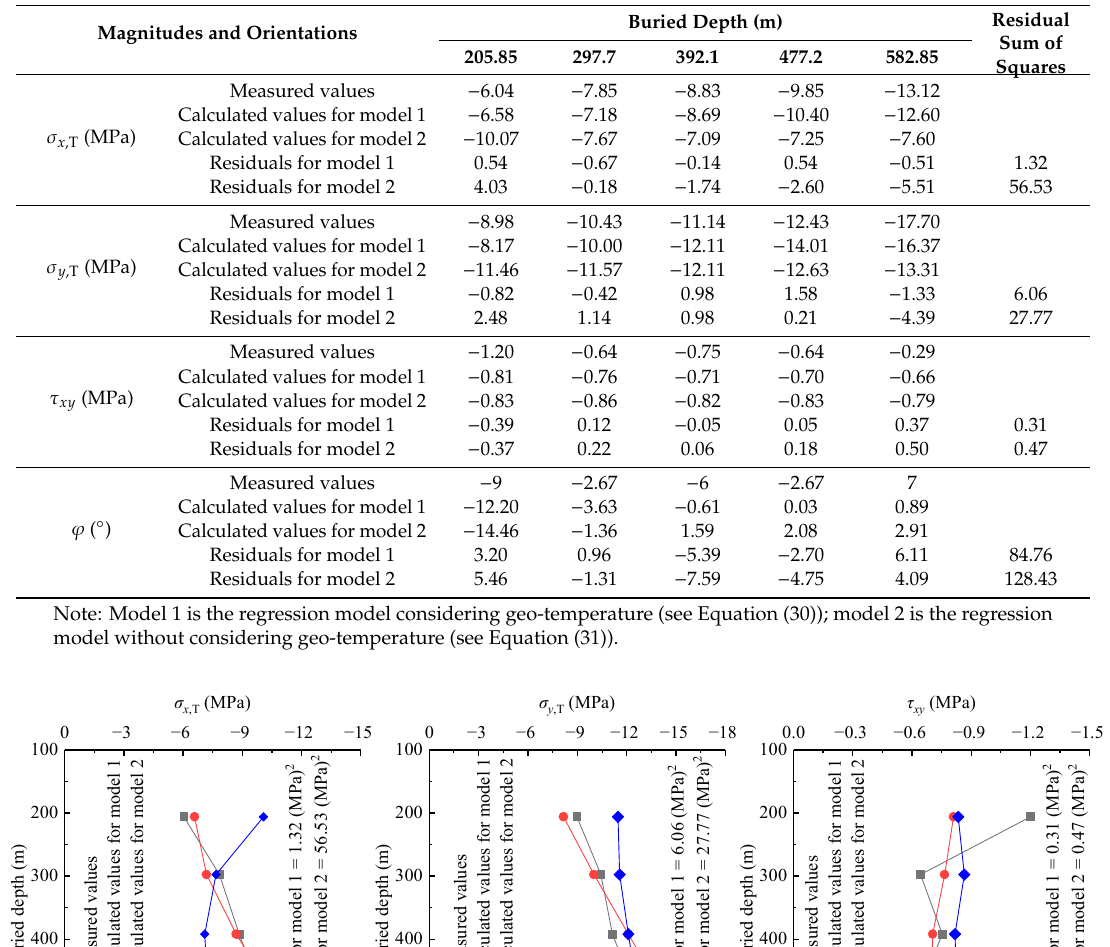
Table 5. Stress magnitudes, stress orientations, residuals, and the residual sum of squares.